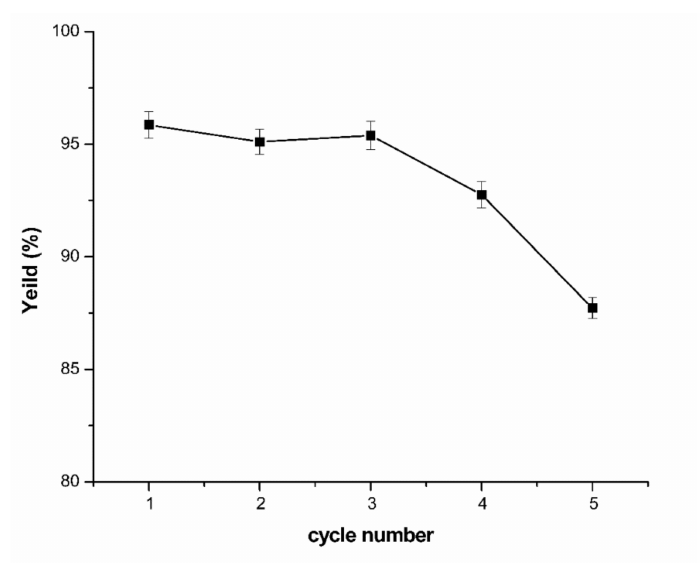
Figure 4. Extraction performance of the impregnation resin.